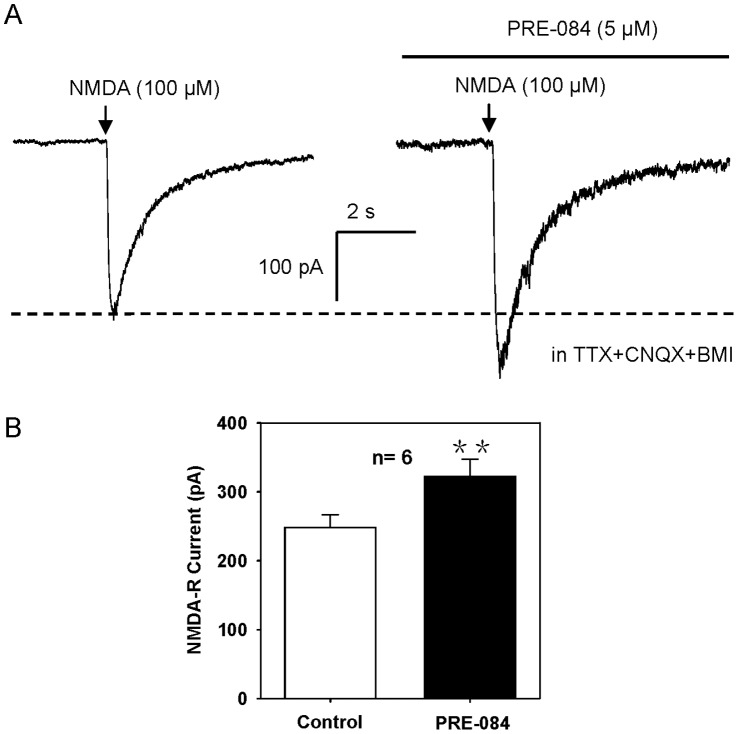
PRE-084 enhances NMDA-induced current.The specific σ1 receptor agonist PRE-084 (5 µM) enhanced NMDA-induced current, as MPH did. Recordings of NMDA-R current were performed in the presence of CNQX (20 µM), TTX (1 µM) and BMI (20 µM), with holding potential of −40 mV. **P<0.01 vs. control, n = 6, paired t-test.